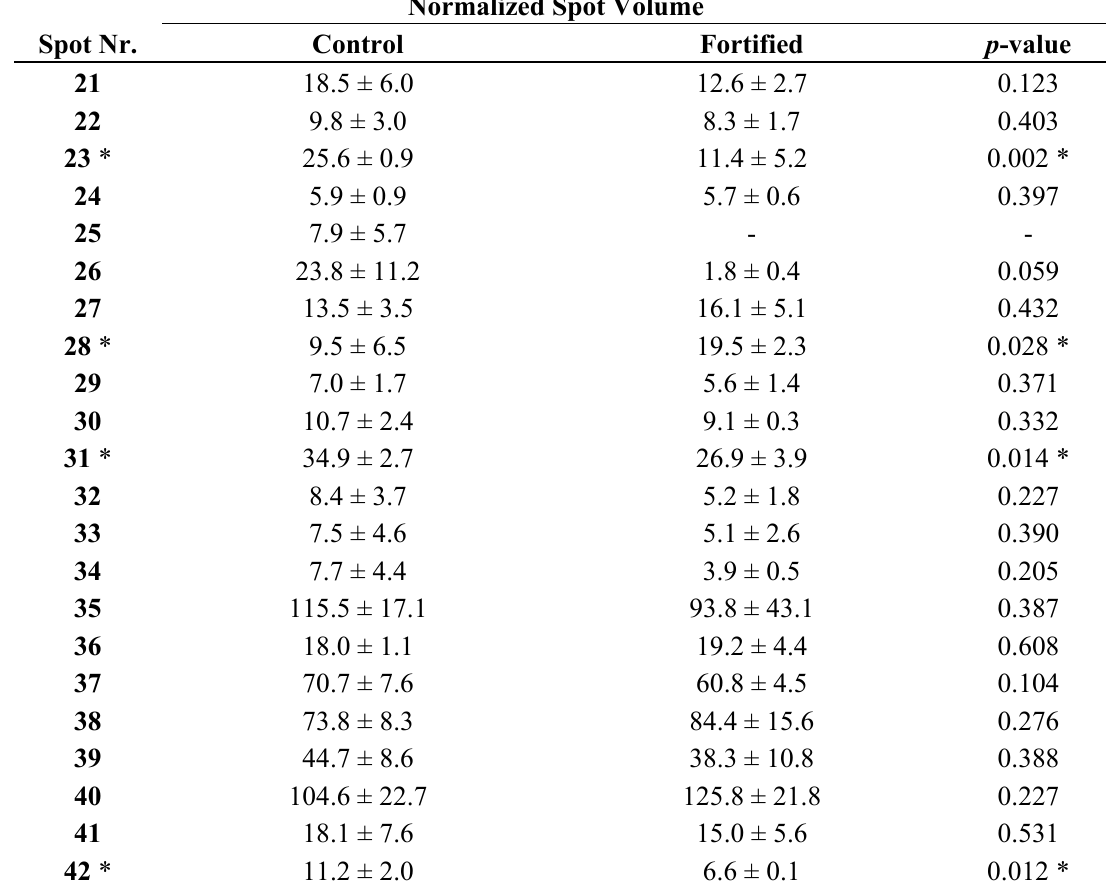
Table 1. Cont. Normalized Spot Volume